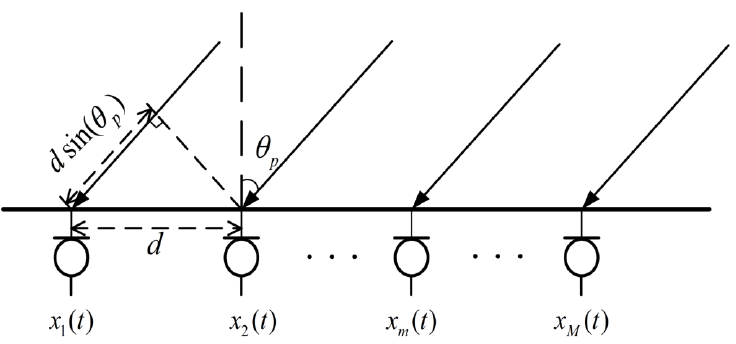
Figure 2. Direction-of-arrival of the antenna